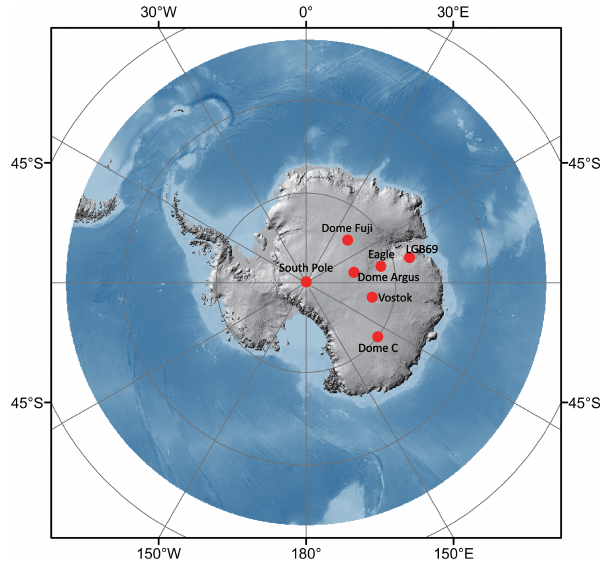
Figure 1. The locations of Dome Argus, Eagle, and LGB69 in Antarctica.